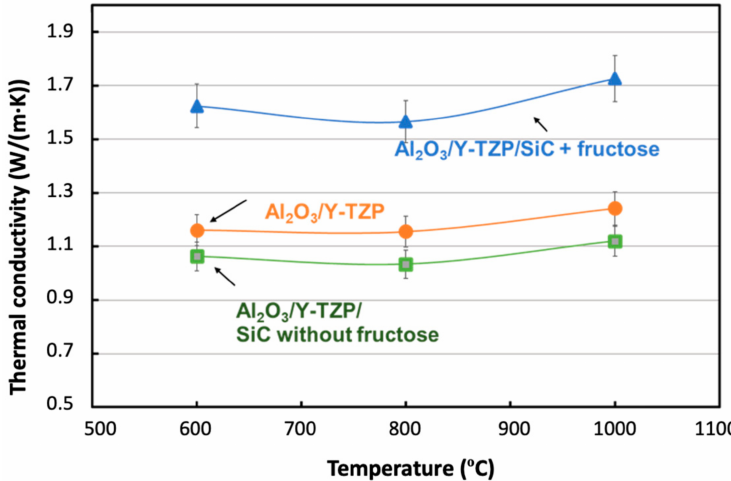
Figure 10. Thermal conductivity of the coatings at different